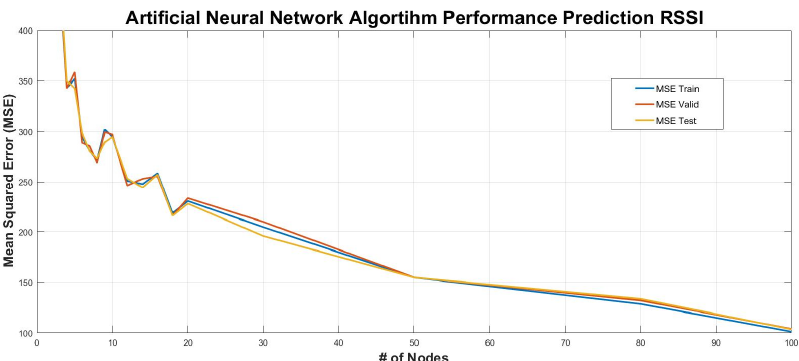
Figure 12. Performance metrics plot for MLP ANN algorithm against different number of hidden layer’s nodes.